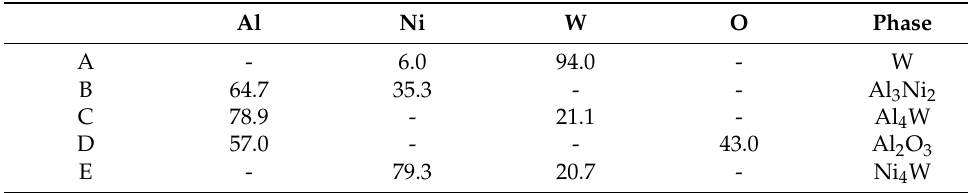
Table 1. EDS results of Figure 7